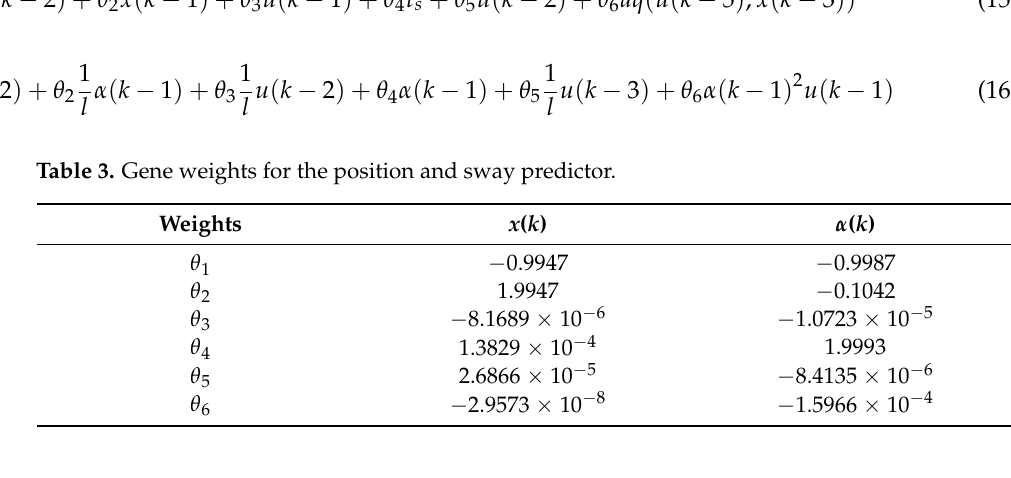
Table 4. Coefficients of the simulation position and sway ARX